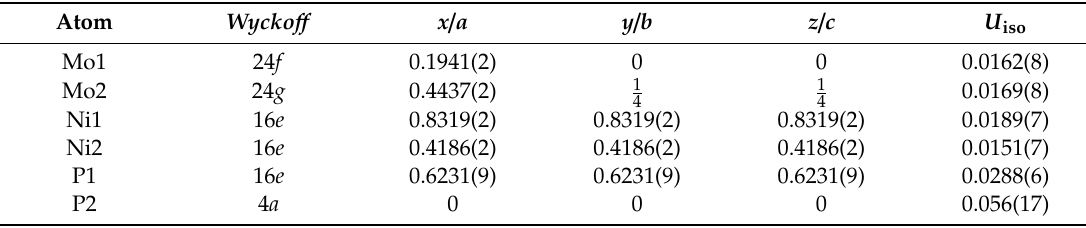
Table 3. Atoms, Wycko ff positions, atom coordinates, and isotropic displacement parameters (Å 2 ) for tsikourasite.